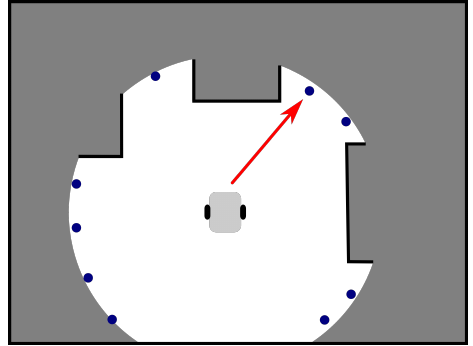
Figure 2. Illustration of the exploration strategy